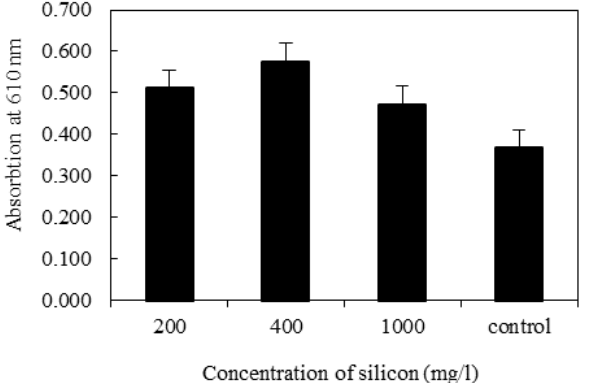
Figure 5: β-1,3-glucanase activity of extract of chili pepper treated with potassium silicate (Kasil®). CI - Control & 4 DAI; TI - Treated & 4 DAI; T - Treated & No